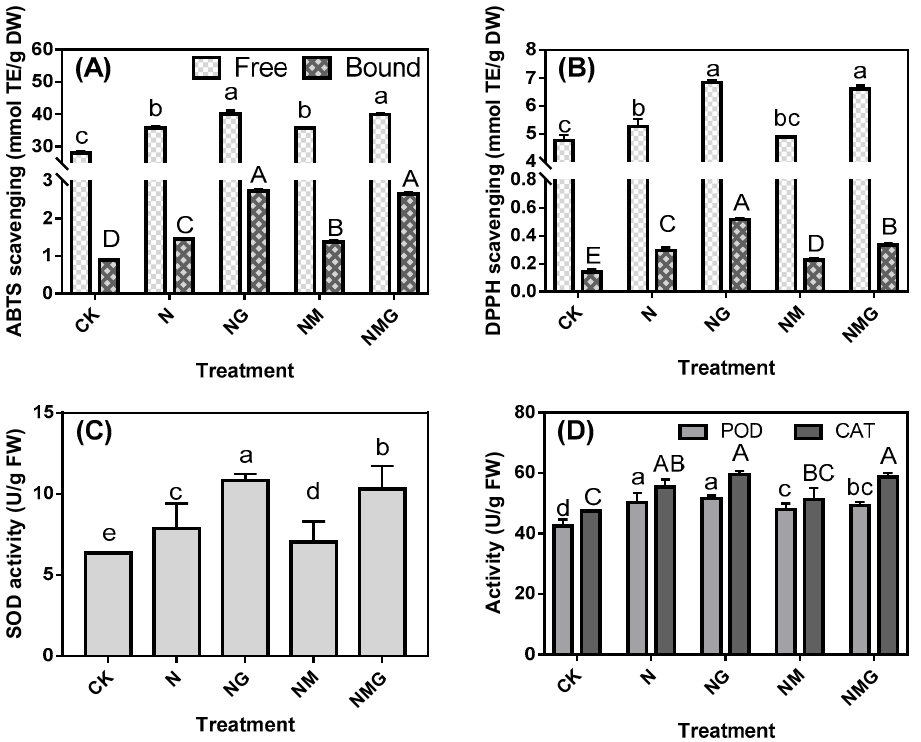
Figure 3. Effects of GABA treatment on 2,2’-azinobis (3-ethylbenzthiazoline-6-sulphonic acid) (ABTS; A ) and1,1-Diphenyl-2-picrylhydrazyl radical 2,2-Diphenyl-1-(2,4,6-trinitrophenyl) hydrazyl (DPPH; B ) Super oxide dimutese (SOD; C ), CAT, and peroxidase (POD; D ) activity in soybean sprouts under NaCl stress. CK, N, NG, NM, and NMG indicate distilled water treatment, 40 mM NaCl treatment, 40 mM NaCl + 5 mM GABA treatment, 40 mM NaCl + 0.2 mM 3-MP treatment, and 40 mM NaCl + 0.2 mM 3-MP + 5 mM GABA treatment, respectively. Error bars represent standard deviation. Values in the same measured category bearing different uppercase letters ( A – E ) or lowercase letters (a–e) are significantly different ( p <